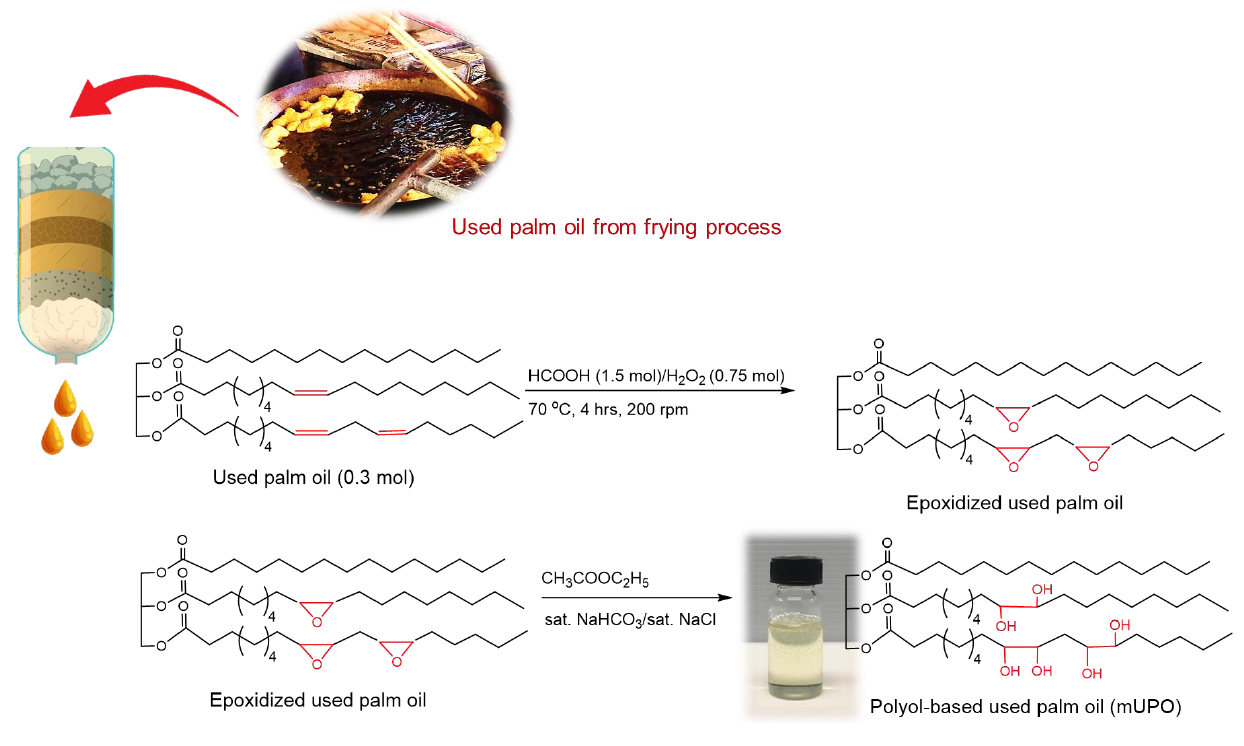
Figure 1. The modification process and chemical structure of UPO and mUPO. Table 2. Summary of properties of UPO and mUPO.